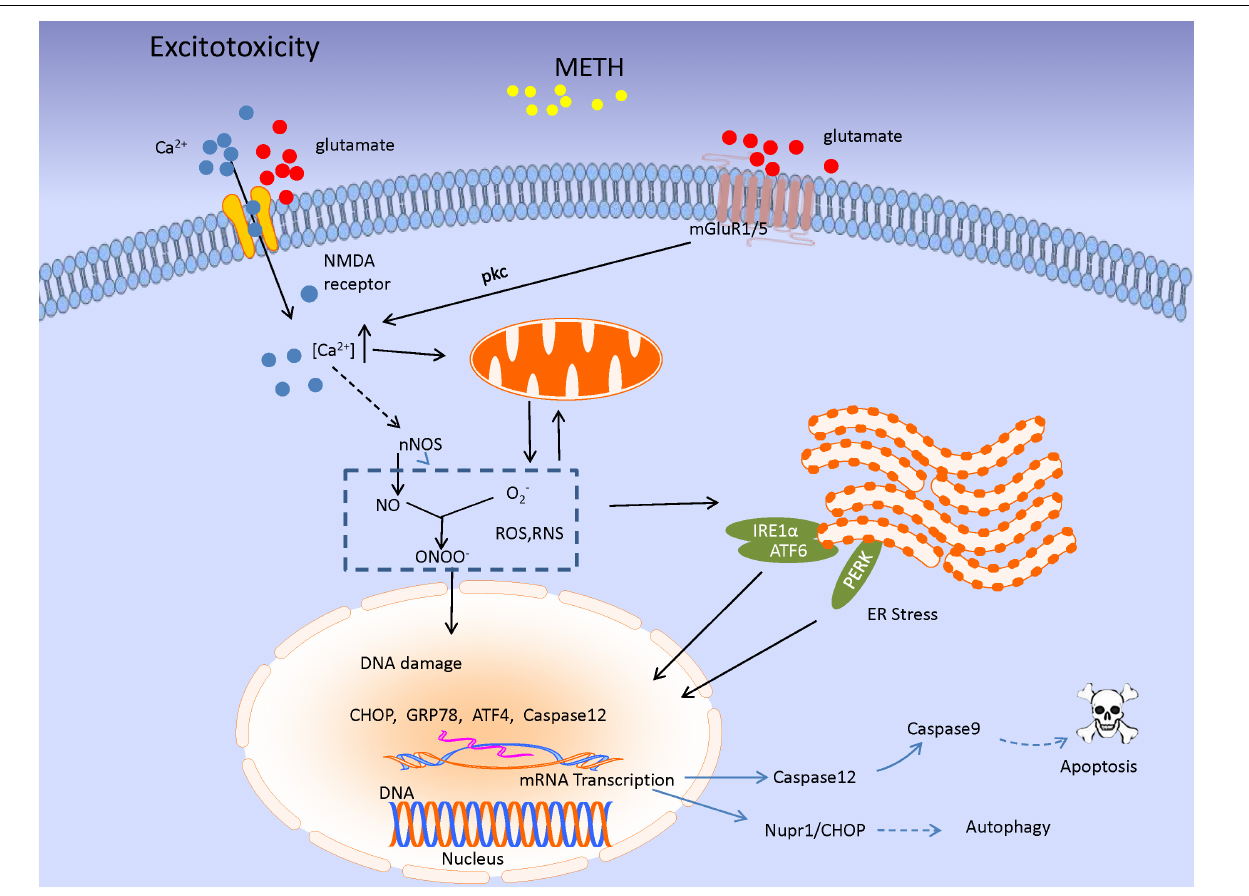
FIGURE 3 | The image shows the excitatory toxicity model of METH. METH-mediated increase in extracellular glutamate level leads to stimulation of mGluR1/5 or N -methyl- D -aspartate receptors (NMDARs). mGluR1/5-induced protein kinase C (PKC) activation phosphorylates and upregulates NMDAR function, leading to Ca 2 + influx. The signaling results in enhancement of cytosolic Ca 2 + level associated with nNOS activity, leading to NO production. NO acts as an ER stressor, and then, UPR signaling pathway would be initiated in response to ER stress through three ER transmembrane mediators [inositol requiring protein-1 (IRE1) α , activating transcription factor-6 (ATF6), and protein kinase RNA-like ER kinase (PERK)]. Subsequently, the mediators lead to special genes transcription as CHOP, GRP78, and Caspase 12 which triggering a series of cascade involving apoptosis and